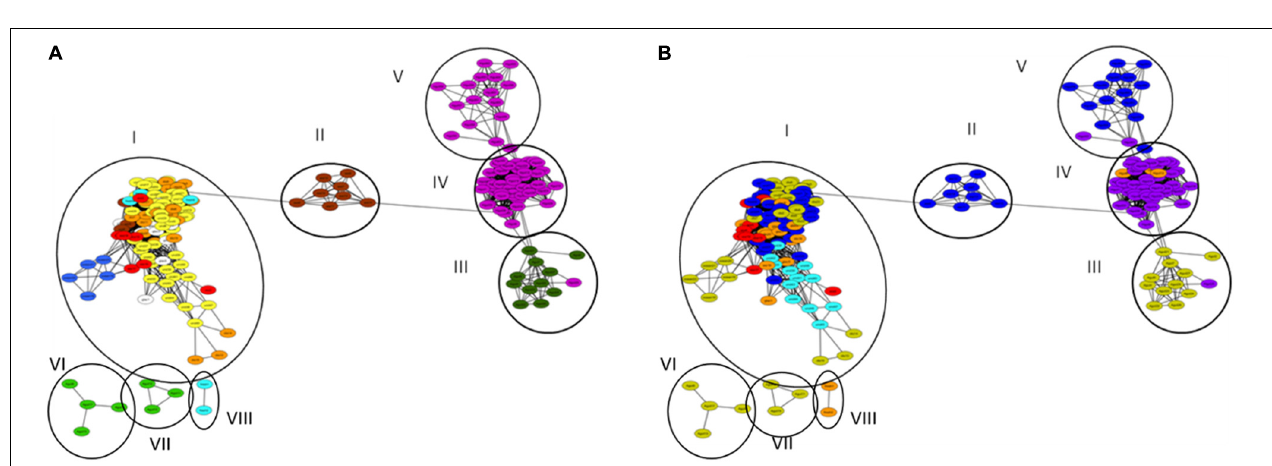
FIGURE 3 | β -lactamase homologs gene network of analyzed metagenomes. Circles and Roman numerals represent clusters defined using network analyzer in Cytoscape. (A) Network color-code based on environment: bovine rumen (light green); bovine feces (dark green); human feces (purple); aerobic (activated sludge) municipal wastewater treatment (red), anaerobic municipal waste and food digestion reactors (brown); non-agricultural soil (yellow); agricultural soil (orange); glaciers (white); fresh water (light blue); marine (dark blue). Anaerobic municipal waste samples were primarily associated with Cluster I, whereas anaerobic food digesters all grouped in Cluster II. (B) Network color-coded based on geographical origin: United States (blue); Israel (light blue); Northern Europe (purple), Central Europe (orange); China (red); Australia